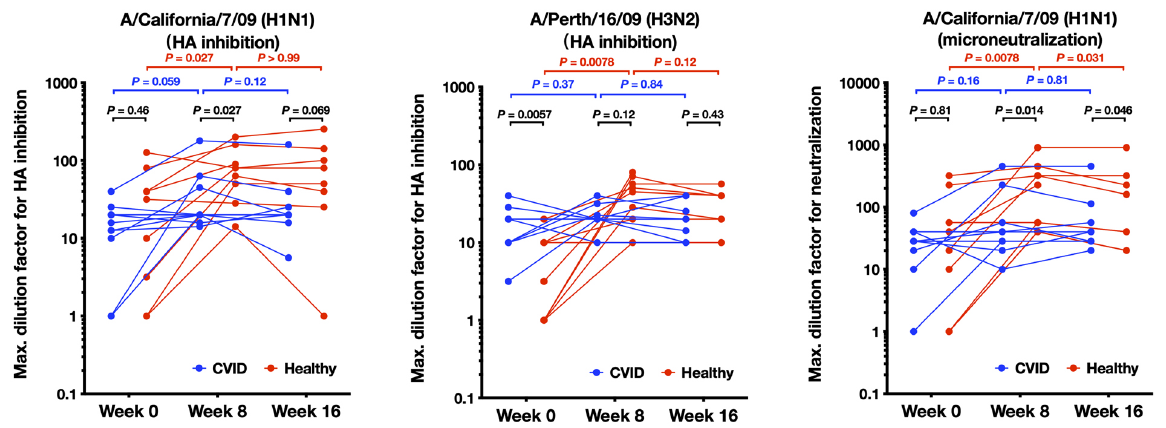
Figure 2. Humoral immune response to influenza vaccination in patients with CVID and healthy participants. The Geometric Mean Titer (GMT) of the serum required for the neutralization of the indicated HA antigen is shown on the y-axis. Higher number indicates higher neutralizing antibody titers and stronger neutralizing antibody activity. Results were the average of 3 replicate experiments. GMT for hemagglutination inhibition toward A/California/7/2009 (H1N1)-like HA, A/Perth/16/2009 (H3N2)-like HA, and by microneutralization against A/California/7/2009 (H1N1)-like HA are shown for 11 patients with CVID and 9 healthy controls at week 0 and week 8, and 9 patients with CVID and 8 healthy controls at week 16, due to missed visits at week 16. Comparisons are made with the Wilcoxon matched pairs